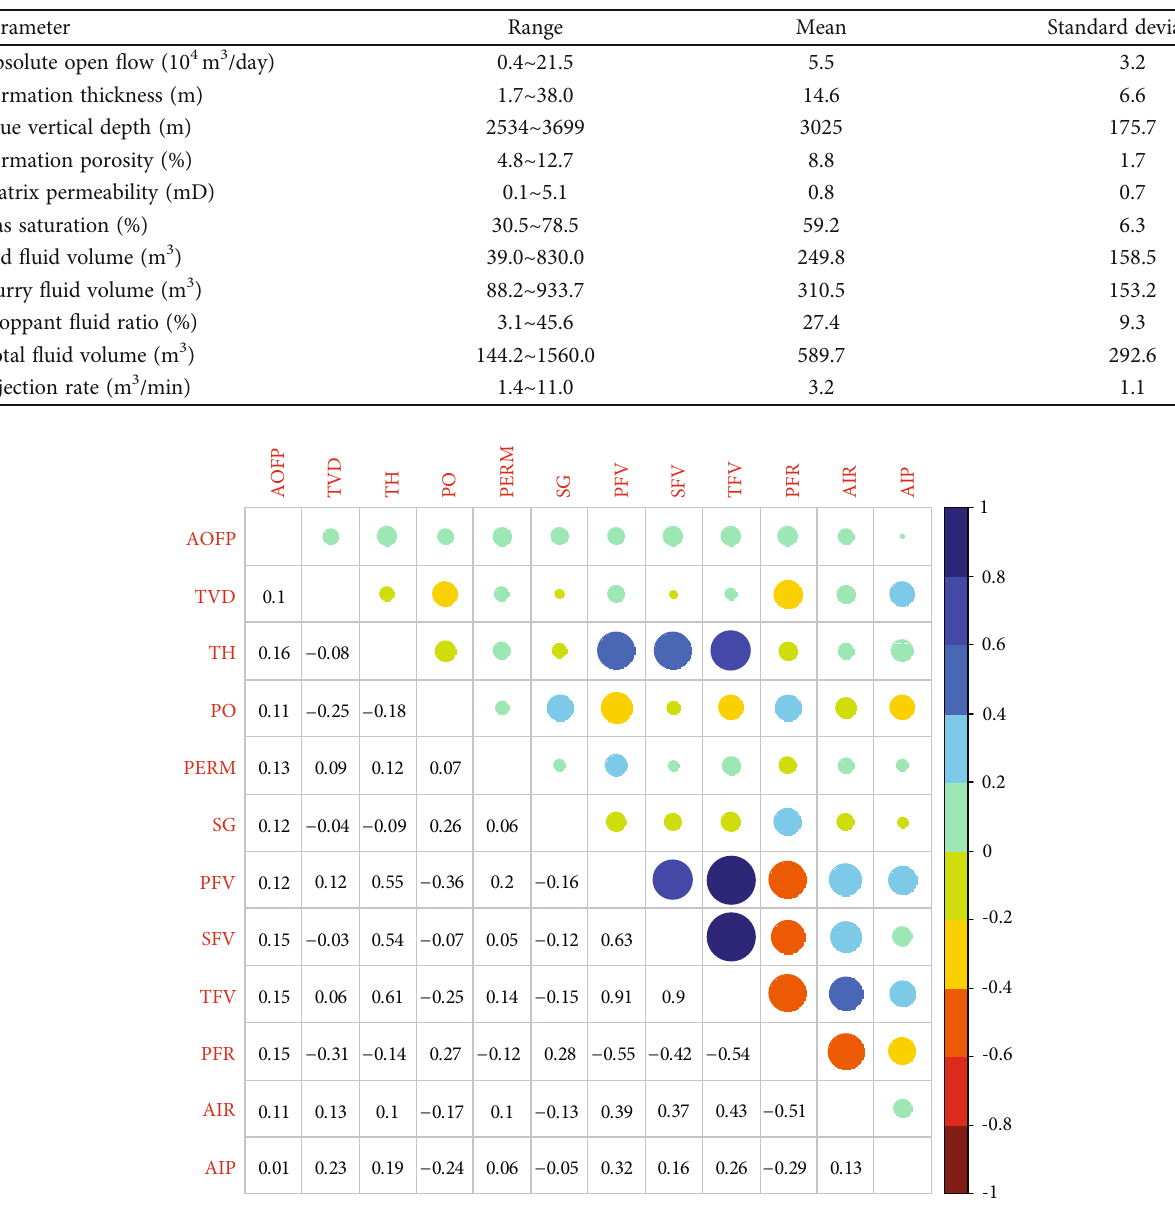
Figure 4: The Pearson covariance matrix between